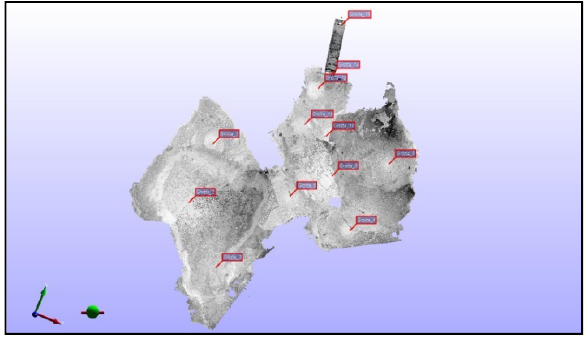
Figure 3. Location of the scans inside the cave